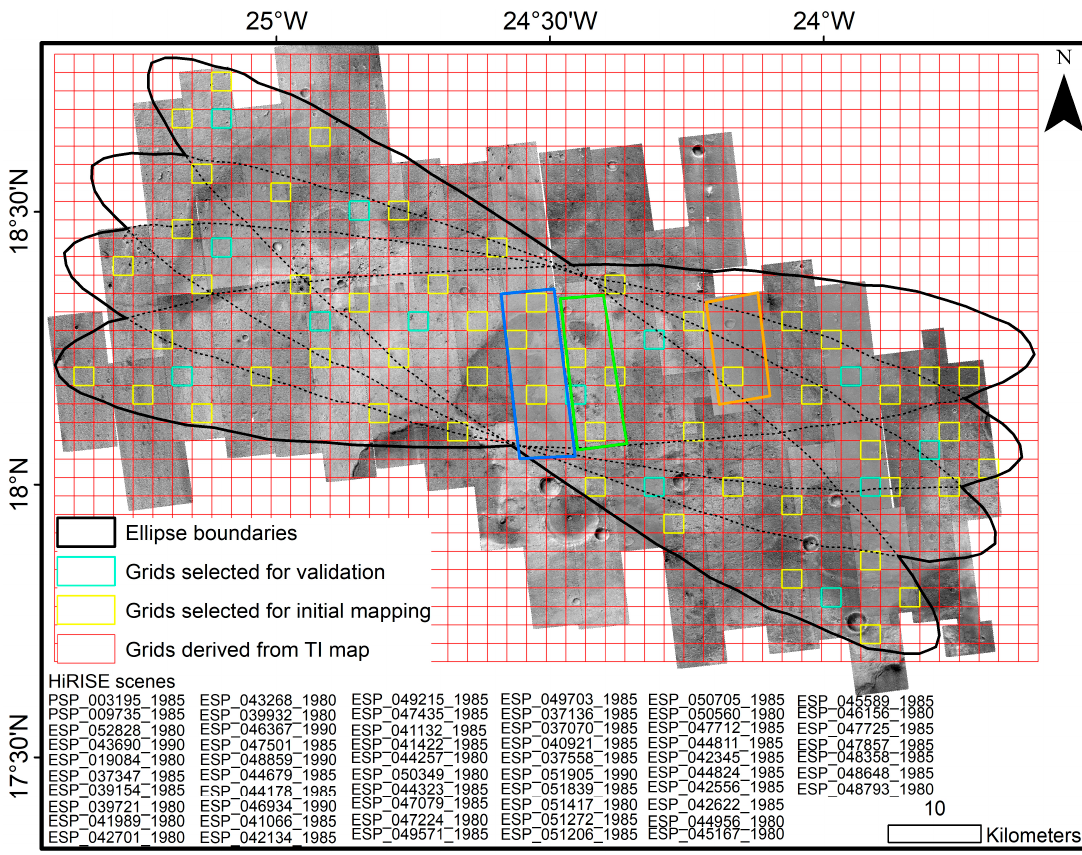
Figure 2. Oxia Planum in high-resolutions. A total of 57 high resolution imaging science experiment (HiRISE) scenes have been used to make the composite and perform the mapping. The orange, green, and blue rectangles highlight the regions with available HiRISE digital terrain models (DTMs) DTEEC_003195_1985_002694_1985_L01, DTEEC_036925_1985_037558_1985_L01, and DTEEC_009880_1985_009735_1985_L01.IMG, respectively. HiRISE image and DTM credit: NASA/JPL/University of Arizona.